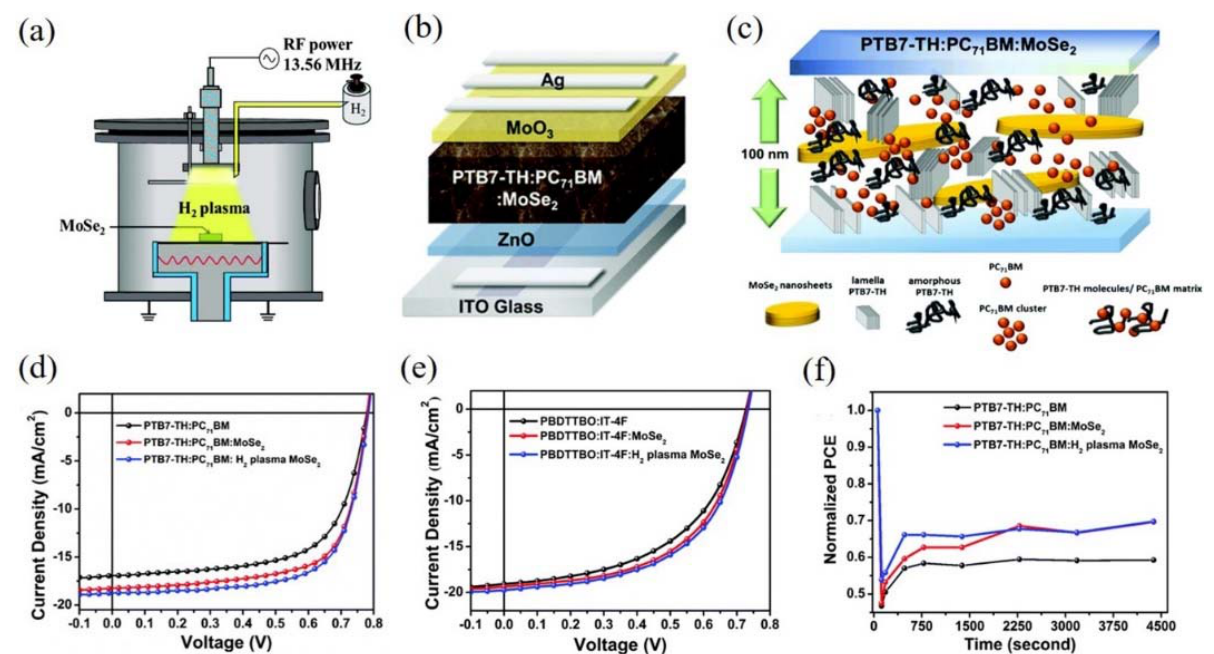
Figure 3. ( a ) Schematic representation of the H 2 plasma treatment; ( b ) The device structure of inverted OSCs based on PTB7-Th:PC 71 BM with MoSe 2 ; ( c ) Schematic diagram of the interplay of MoSe 2 with PTB7-TH and PC 71 BM; J-V characteristics of ( d ) PTB7-Th:PC 71 BM and ( e ) PBDTTBO:IT-4F devices without MoSe 2 and introducing MoSe 2 with and without hydrogen plasma treatment; ( f ) Stability of PCE values of devices based on PTB7-TH:PC 71 BM without MoSe 2 and adding MoSe 2 with and without hydrogen plasma treatment at 100 °C. Reprinted with permission form [65]. Copyright 2019 The Royal Society of Chemistry.